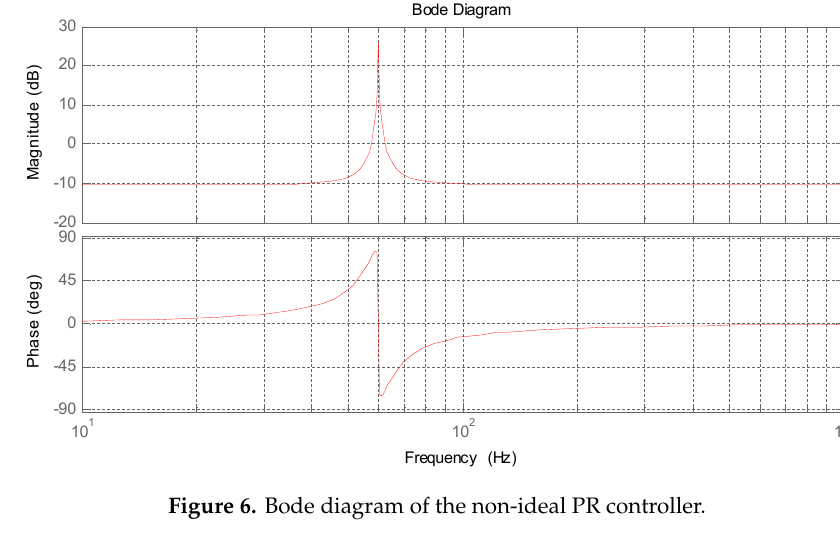
Figure 6. Bode diagram of the non-ideal PR controller.